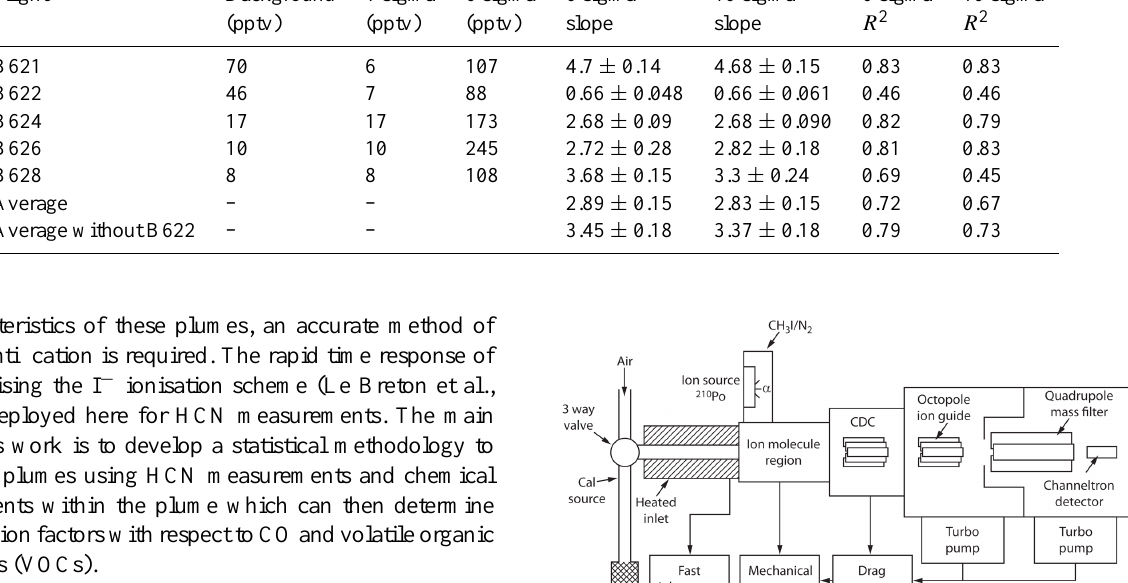
Table 1. HCN:CO NEMRs (in pptvppbv − 1 ) for 5 flights during BORTAS campaign in plumes determined by 6 or 10 sigma above back- ground and R 2 of correlations. NEMR units are pptppb − 1 . Flight